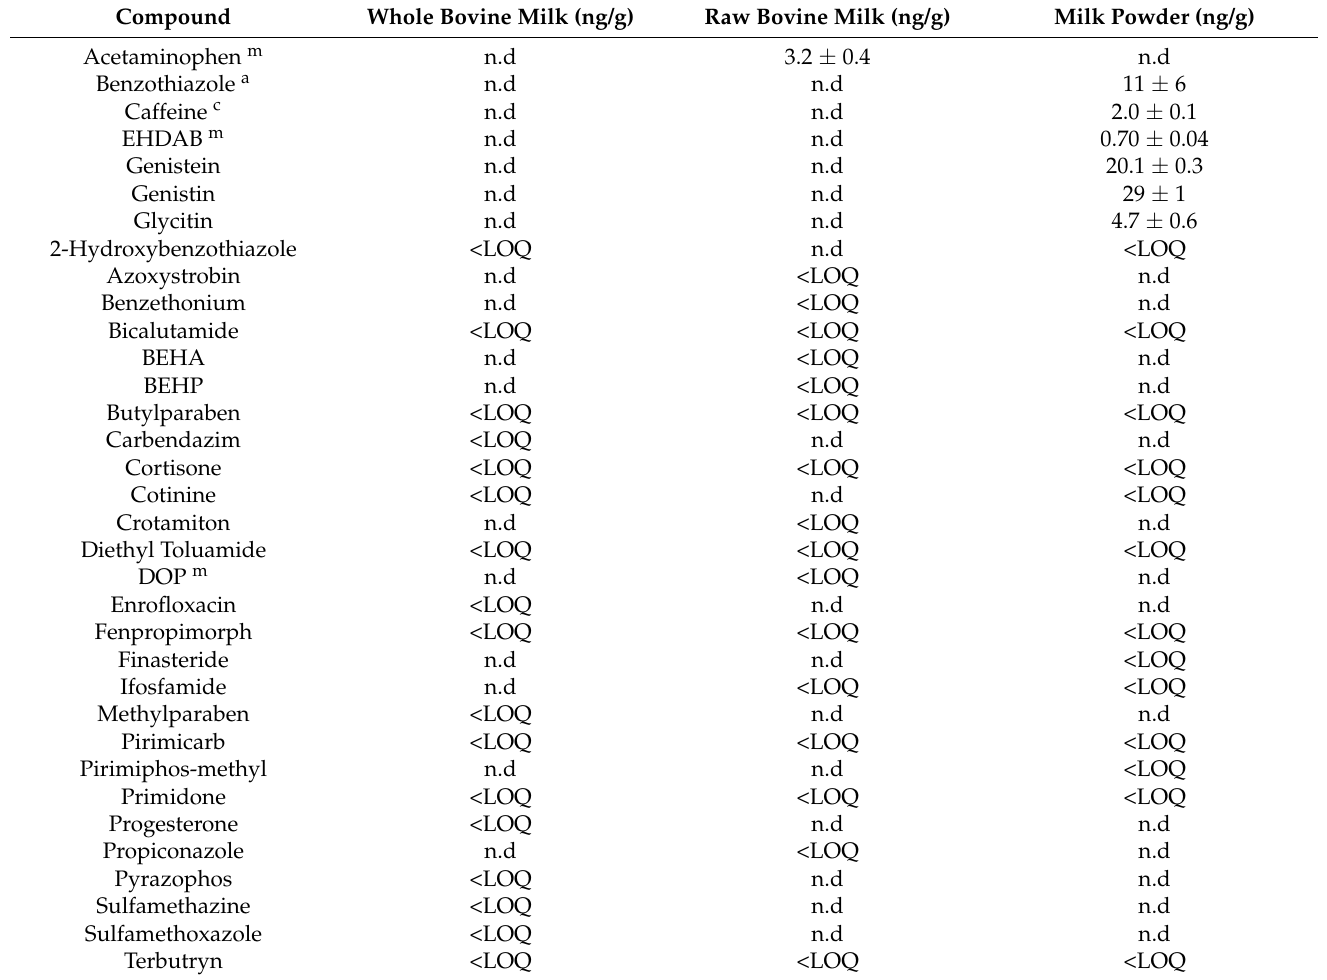
Table 4. Target analysis results: concentration of xenobiotics (95%, 2 s) in commercial milk samples. Compound Whole Bovine Milk (ng/g) Raw Bovine Milk (ng/g) Milk Powder (ng/g) Acetaminophen